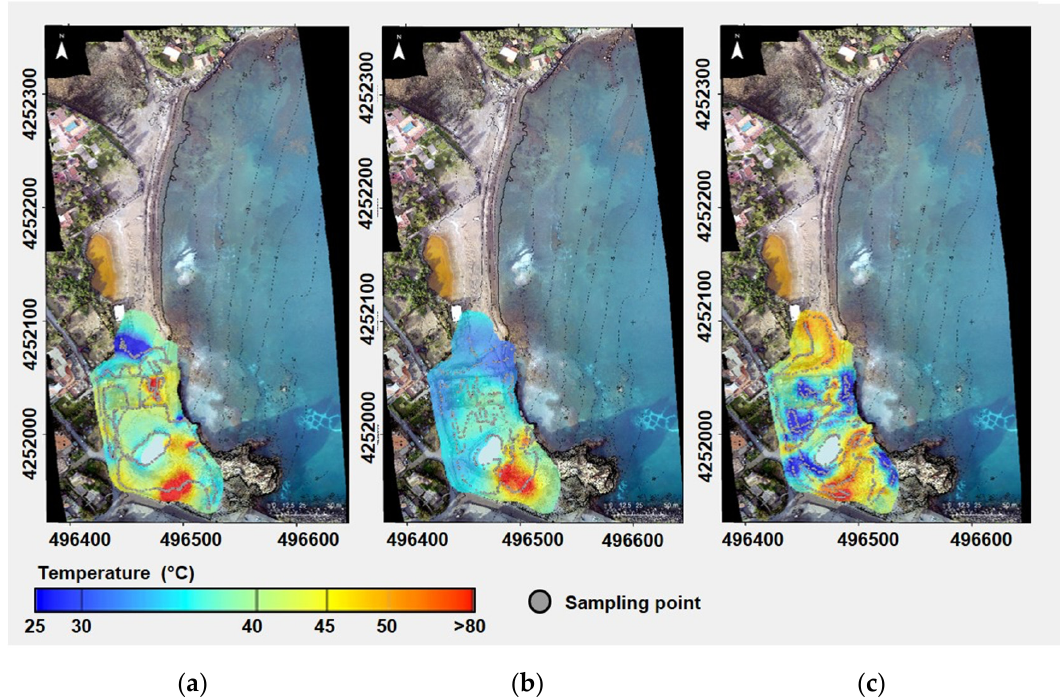
Figure 3. Maps of soil temperatures derived from interpolation of the datasets acquired by Pyrogips in ( a ) July 2014; ( b ) July 2015; ( c ) September 2015.